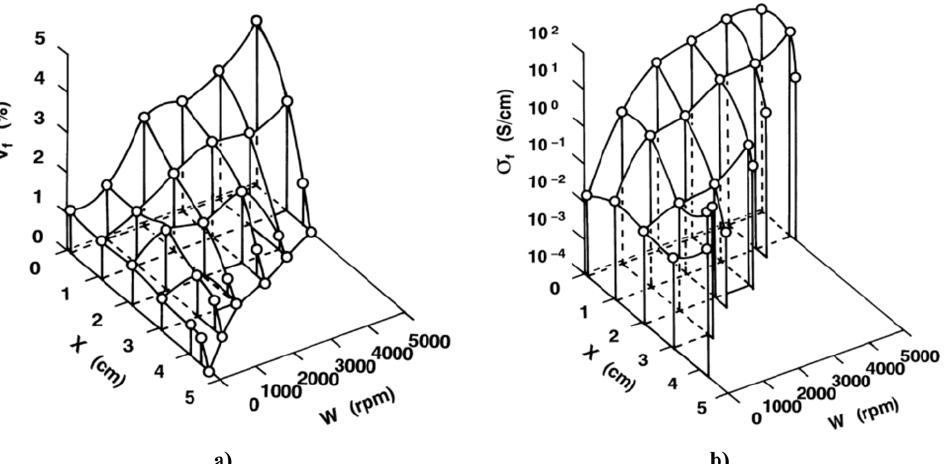
Figure 48. Three-dimensional relationship between ( a ) the volume fraction of carbon fibers, V f (%), and ( b ) the electrical conductivity as functions of the distance X from the bottom to the center of the specimen and the maximum rotation speed, W. Reprinted from [123], Copyright 1997, with permission from Elsevier.